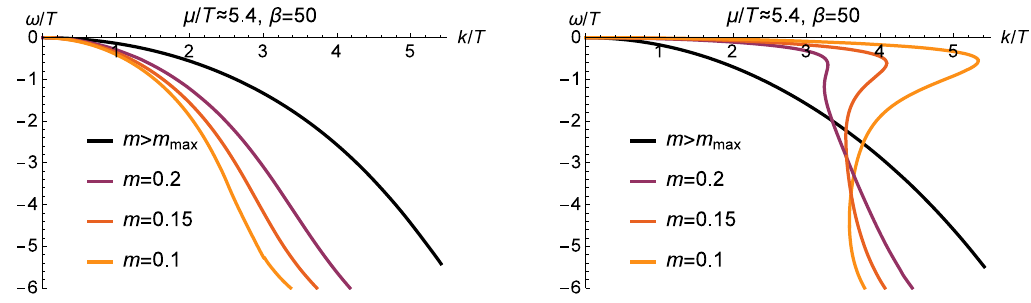
Figure 13 . The di(cid:11)usion QNM (left) and CM (right) at (cid:22)=T (cid:25) 5 : 4 and (cid:12) = 50.